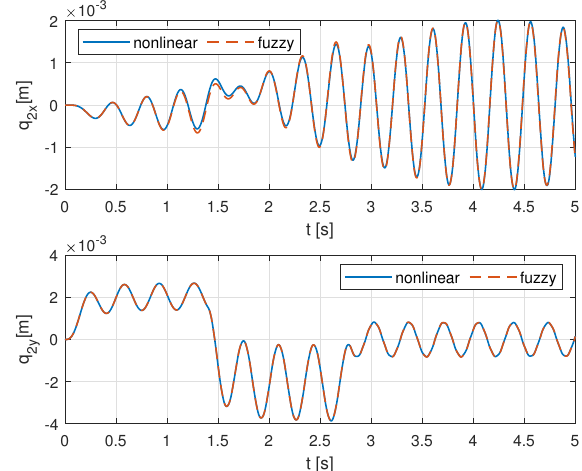
Figure 7. Appendage 2 displacement.